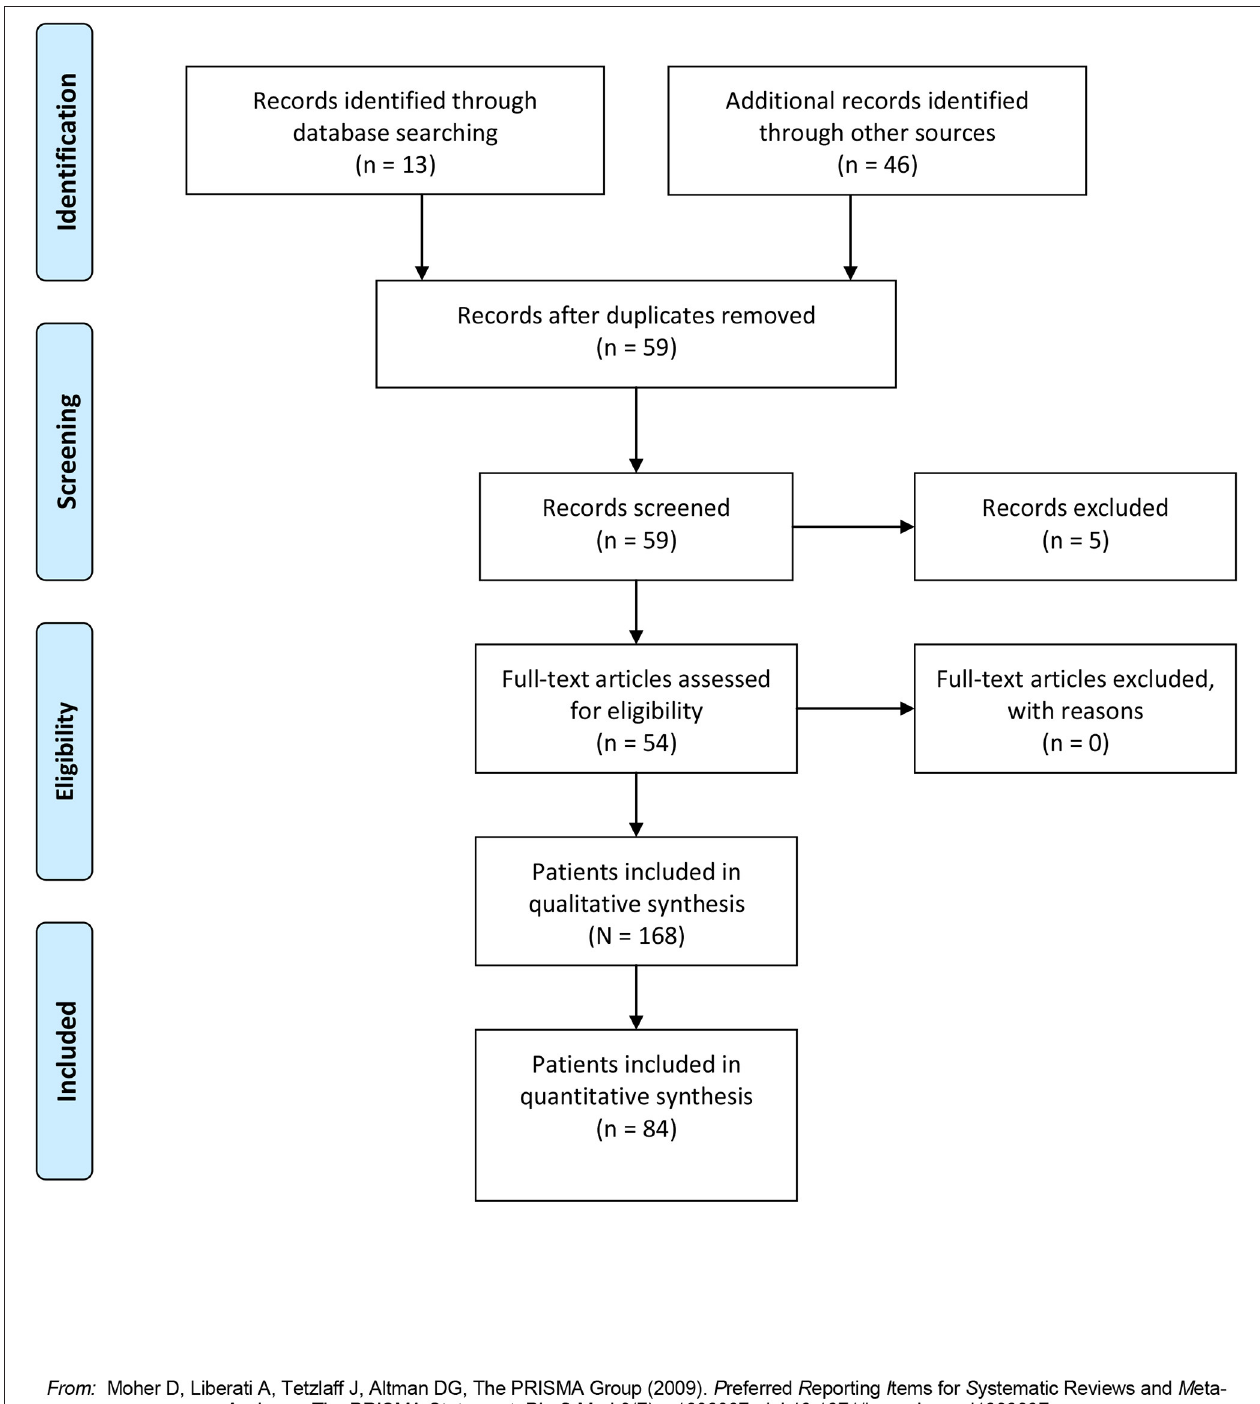
FIGURE 1 | PRISMA flow